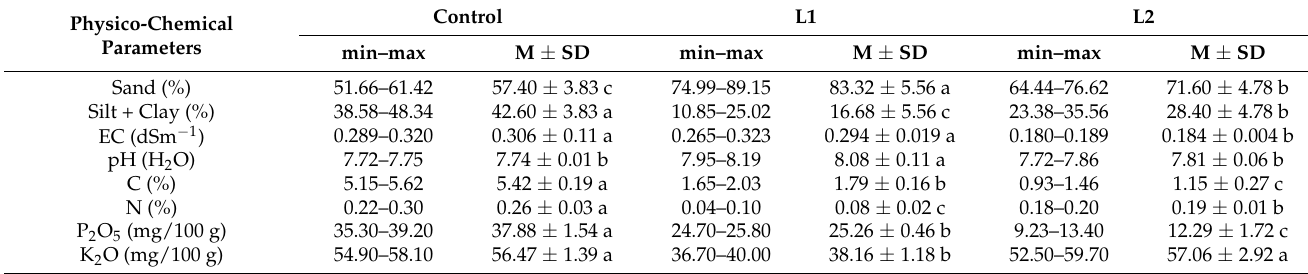
Table 1. Physico-chemical characteristics of fly ash at lagoons of different ages (L1 and L2) and soil